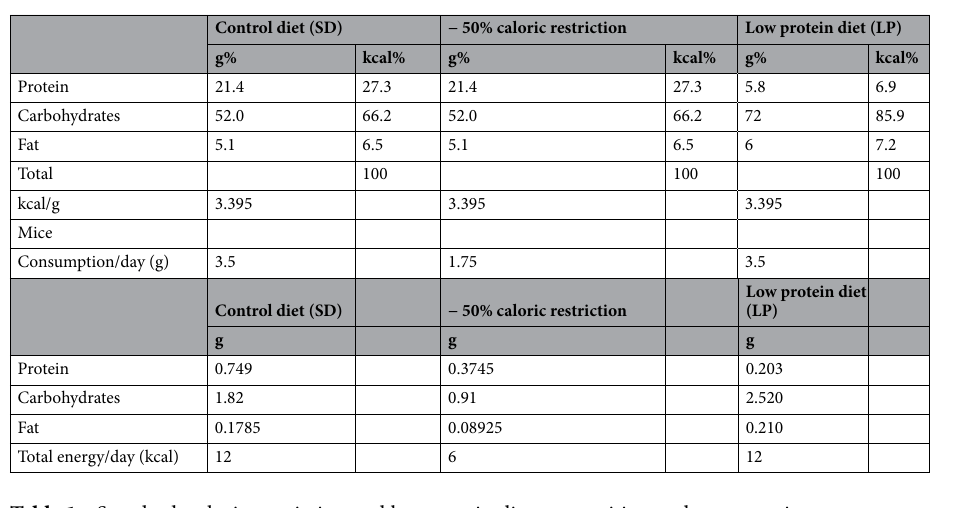
Table 1. Standard; caloric restriction and low protein diet composition and